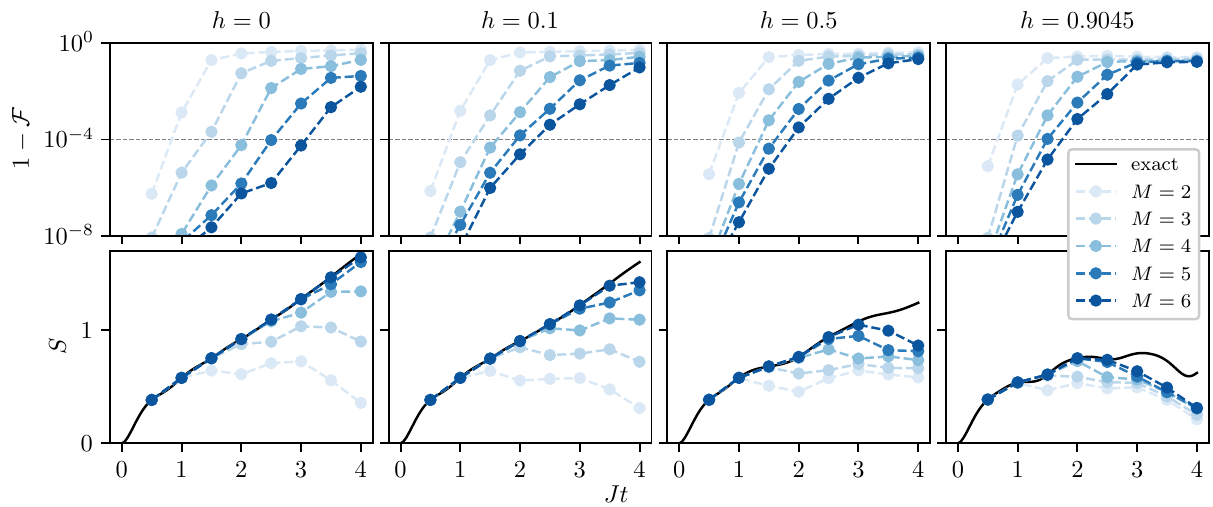
FIG. 2. Quantum circuit representation of order M of quantum states generated under nonequilibrium dynamics. The Hamiltonian is given in Eq. (1) for a chain of length N = 31 with transverse field g = 1.4 and data shown for h = 0, 0.1, 0.5, 0.9045. Top row shows the fidelity F defined in Eq. (2), compared with MPS with bond dimension χ = 1024. The bottom row shows the half chain von Neumann entanglement entropy S for the quantum